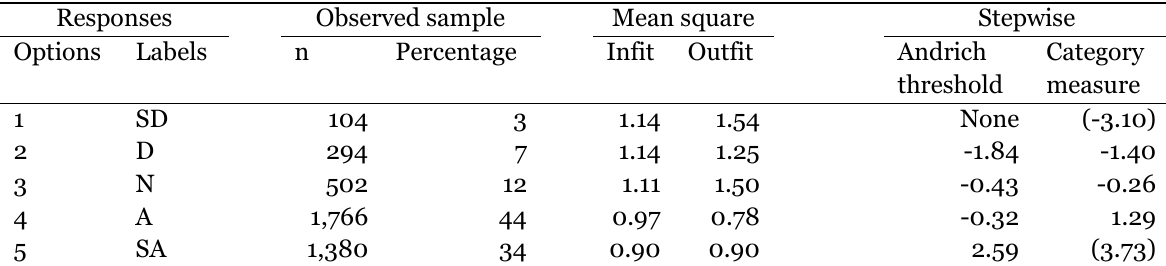
Category Structure